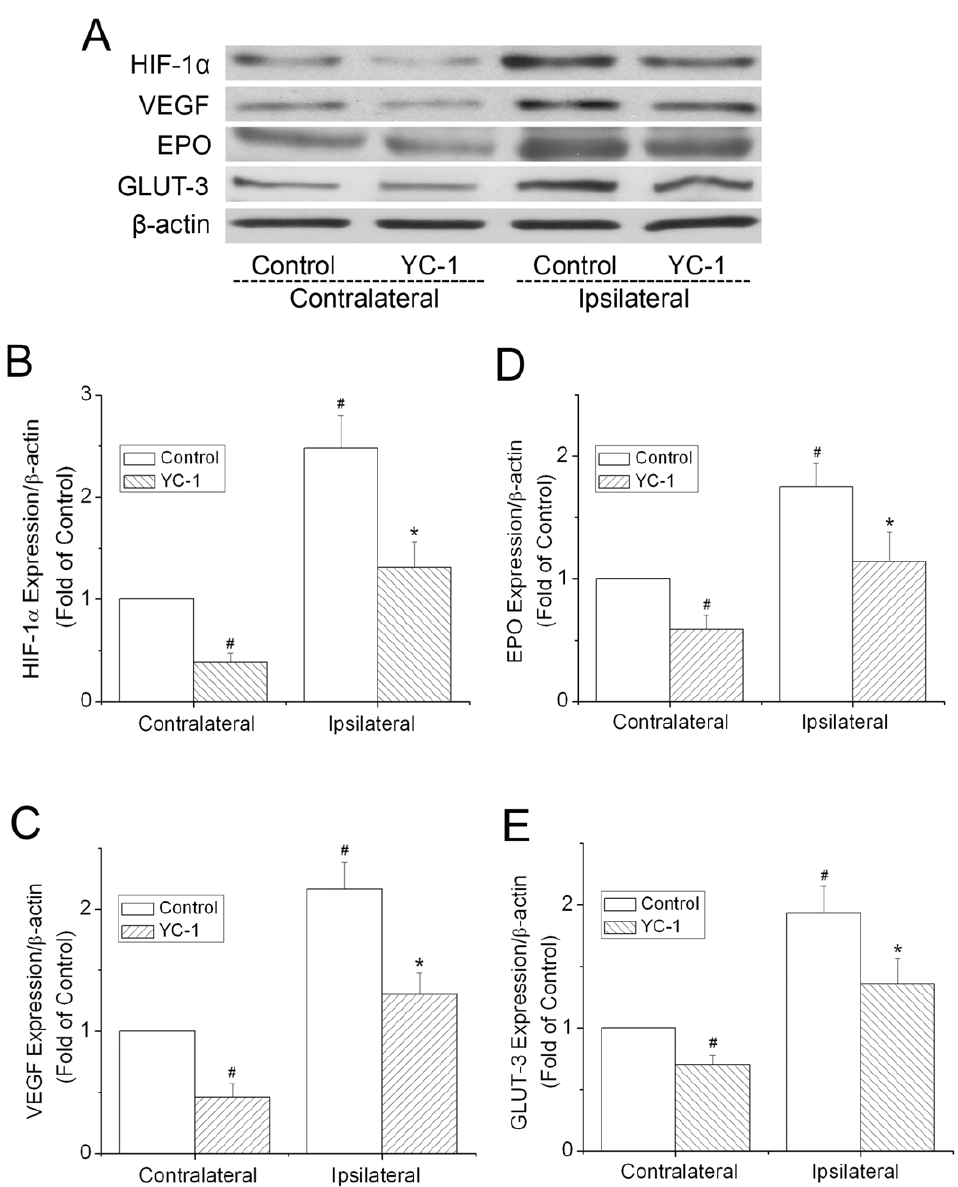
Figure 2. Effect of YC-1 on the expression of HIF-1 in ischemic brains. The protein levels of HIF-1 a and its down-stream proteins EPO, VEGF, and GLUT-3 were analyzed by western blotting in brains from rats subjected to 90 min ischemia and 24 hr reperfusion. Rats received YC-1 (2 mg/kg, i.v.) at 24 h and 30 min prior to the onset of ischemia. ( A ) Representative Western blots of HIF-1 a and its down-stream proteins. ( B ) Quantification of the HIF-1 a protein level. ( C ) Quantification of the VEGF protein level. ( D ) Quantification of the EPO protein level. ( E ) Quantification of the GLUT-3 protein level. Values were normalized to b -actin and contralateral hemispheres of control animals. Values are means 6 SEM, n=5. # p , 0.05 vs. the contralateral hemisphere of control animals, * p , 0.05 vs. the ipsilateral hemisphere of control